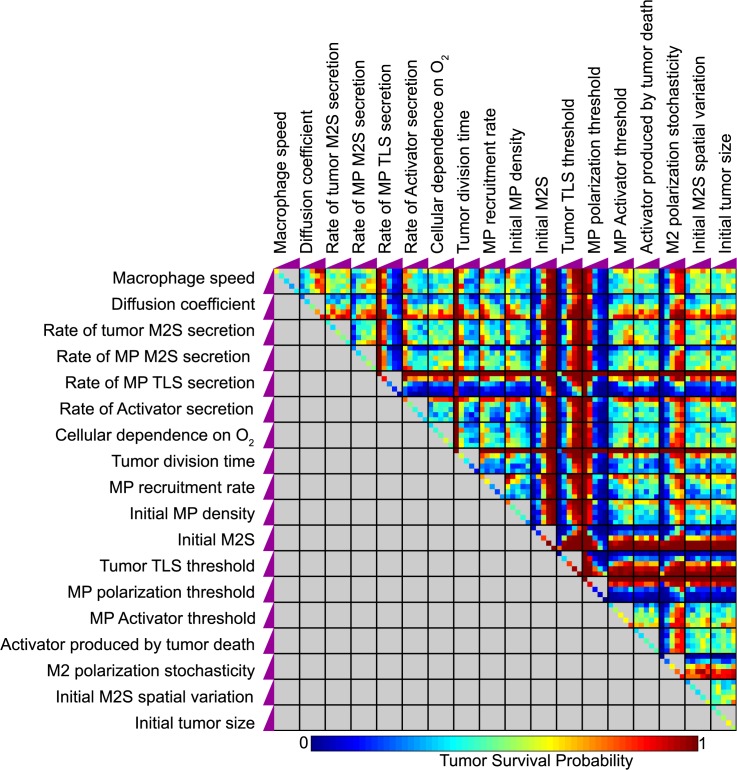
Systematic multi-parameter sensitivity analysis (MPSA).Parameter sensitivity was evaluated by running simulations using 5 values of each parameter, spanning a single order of magnitude around the base value (see text), and this was performed for each combination of values for each parameter pair. 50 simulation runs were performed for each set of parameter values, and the tally of simulation outcomes is indicated by the color. The change in each parameter magnitude across its range is indicated by its corresponding purple ramps on the boundaries of the plot.